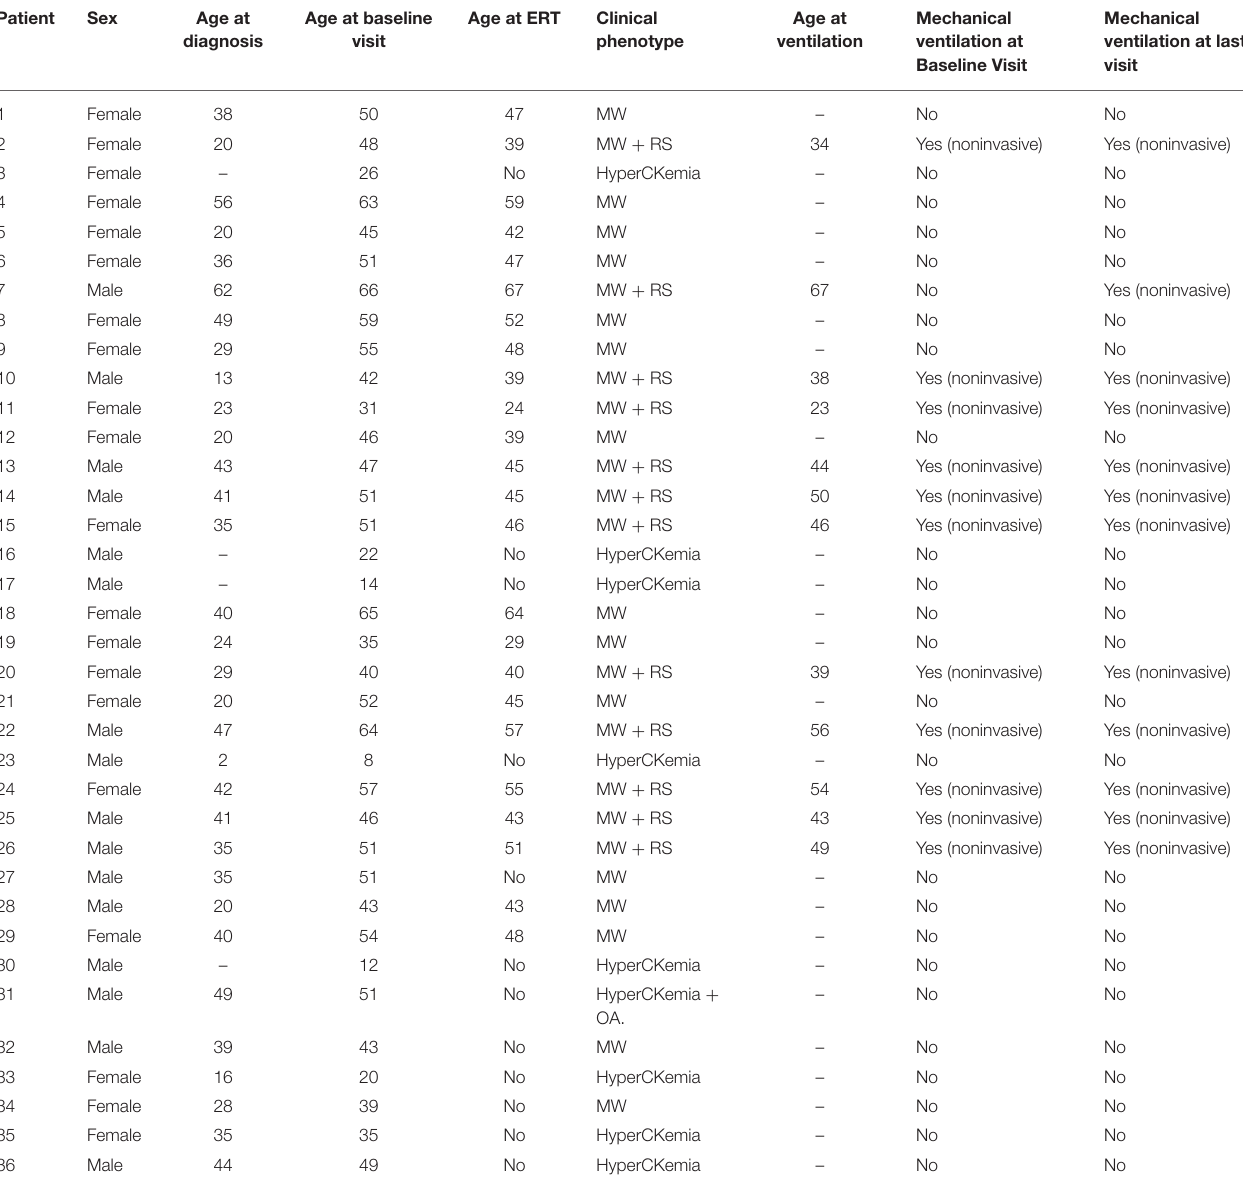
TABLE 1 | Clinical features of the